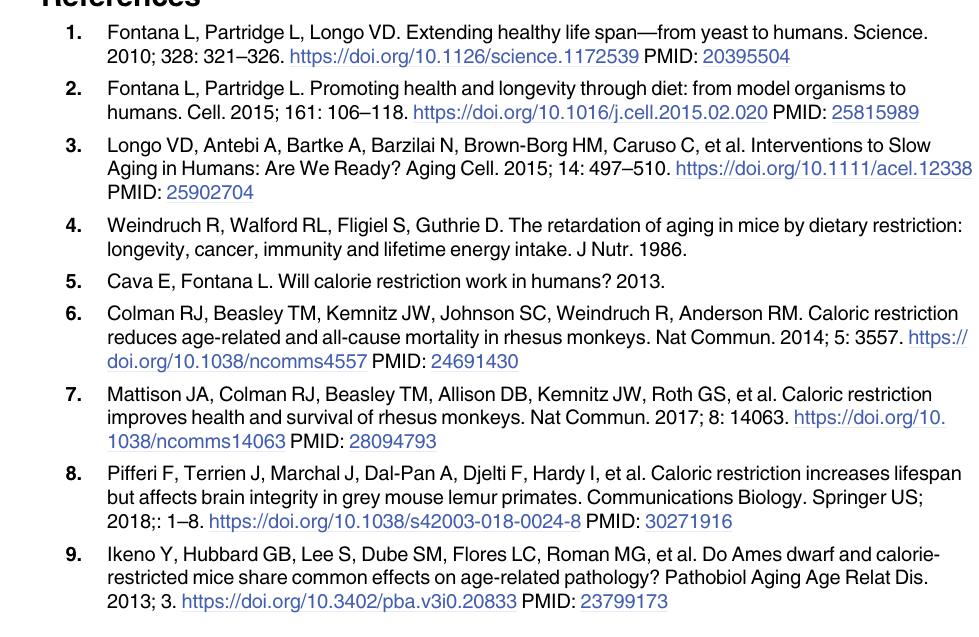
S23 Table. List of barcoded primers used for